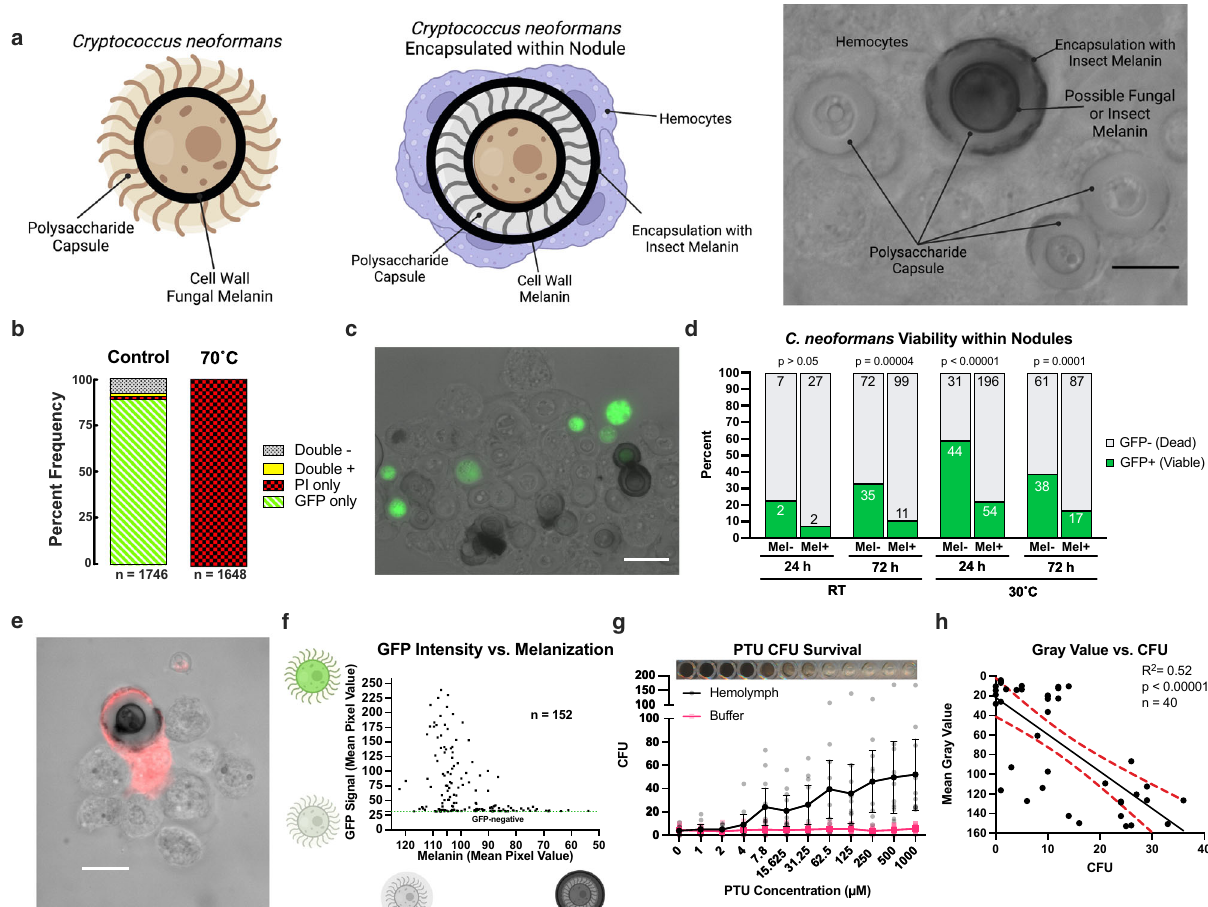
Fig. 1 The melanin-based immune response is implicated in killing C. neoformans during infection. a During infection of G. mellonella , melanized nodules are formed within the hemolymph, which encapsulate C. neoformans . Melanin pigment produced by the fungus, is located typically within the cell wall, while the melanin produced by the insect during encapsulation within nodules is found around and within the fungal polysaccharide capsule. b GFP fl uorescence is lost in heat-killed C. neoformans cells expressing GFP under an actin promoter. Data represents counts of 1640 – 1750 single cells from two separate biological replicates. c Using a GFP-expressing strain of C. neoformans , we can visualize cell viability within the nodule, with living fungi fl uorescing green and dead cells having no signal. d Melanin-encapsulated fungi are statistically less likely to have a GFP-positive signal at 24 h after infection at 30 °C, and at 72 h post-infection at room temperature and 30 °C (Chi-squared test, [ n = 217 cells] p < 0.00001, [ n = 325 cells] p = 0.00004, and [ n = 203 cells] p = 0.0001, respectively) indicating that melanin-encapsulation is associated with fungal death. Numbers within bars represent the number of fungi enumerated in that condition. e In GFP-positive cells, the brighter fl uorescence signal correlates with little to no melanization, with no cells that have strong GFP signals and large amounts of melanin encapsulation ( n = 152 independent cells). Each point represents data from one GFP-positive fungus within nodules from three biological replicates. f Propidium Iodide viability staining does not appear to penetrate the inner space of the nodule where the fungus is located, but the staining does show that the hemocytes surrounding the fungus are not viable. g Colony forming units (CFUs) correlate directly to melanin inhibition using PTU (inset, representative image of the 96-well plate) in vitro, which indicates that melanin has a role in controlling growth of C. neoformans . Line represents the mean and error bars indicate 95% Con fi dence Interval of four independent biological replicates with 10 – 12 total technical replicates. h CFUs also inversely correlated to the Mean Gray Value of these wells, meaning that the darker wells with more melanization had higher CFUs recovered compared to the melanin-inhibited wells (Simple Linear Regression, n = 40 biologically independent wells, p < 0.00001, F = 40.59). Each data point indicates measurements from individual wells from across three biological replicates, red dotted lines represent the 95% con fi dence interval of the linear regression. a – c , f Data shown is representative of three biological replicates. All experiments performed in biological triplicate, with g representing 5 biological replicates. Scale bars represent 10 µ